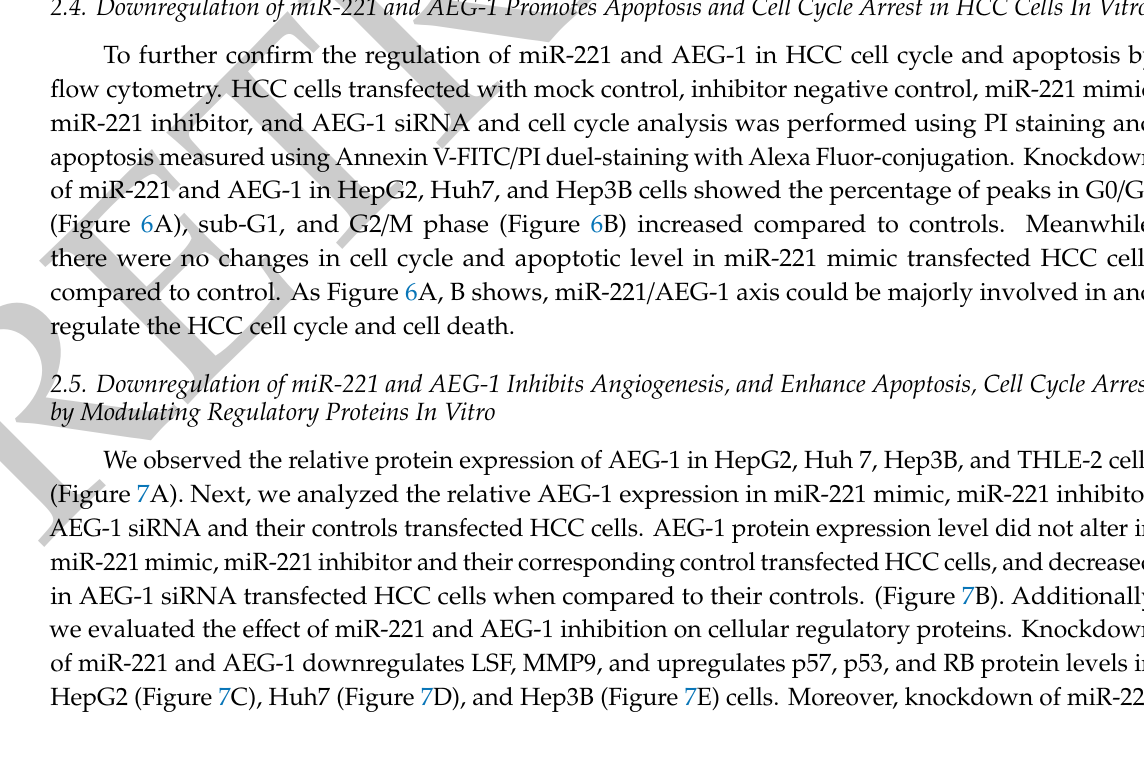
Figure 5. Downregulation of miR-221 / AEG-1 inhibits cell invasion, migration, and angiogenesis in HCC cells. The transwell invasion assay with Matrigel ( A ) and migration assay without Matrigel ( B ) were performed in miR-221 mimic, miR-221 inhibitor, AEG-1 siRNA and their controls transfected HCC cells. Angiogenesis was performed in miR-221 mimic, miR-221 inhibitor, AEG-1 siRNA and their negative control transfected HUVEC cells ( C ). Error bars are presented as mean ± s.d. and ** p < 0.01, *** p < 0.001 compared to the negative controls (scale bar, 100 μ m).